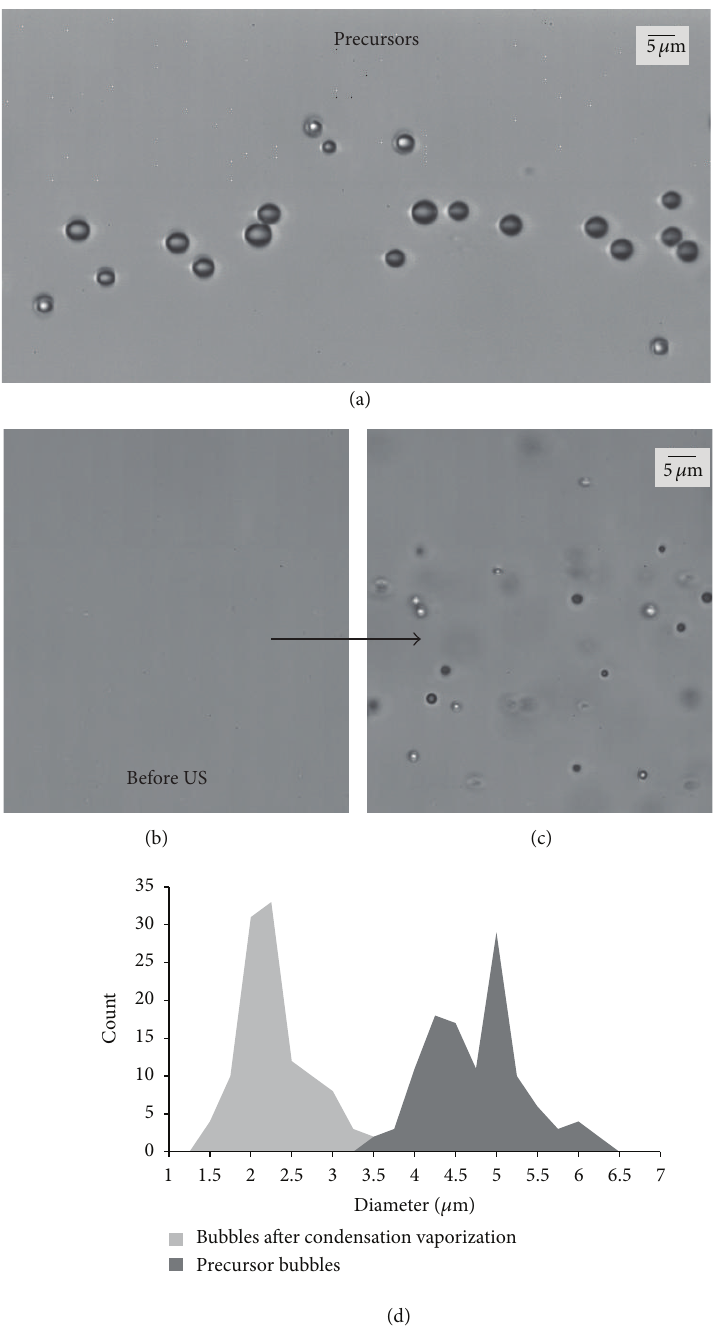
Figure 6: (a) Optical images of size-selected precursor microbubbles; (b) optical images of bubbles produced from vaporized droplets generated bymicrobubblecondensation ofthesize-selected precursorbubbles; (c)histogramof shiftinbubbledistributionbetween precursor microbubbles ( 𝑁 = 116 ) and vaporization-produced bubbles ( 𝑁 = 118 ). Unpublished